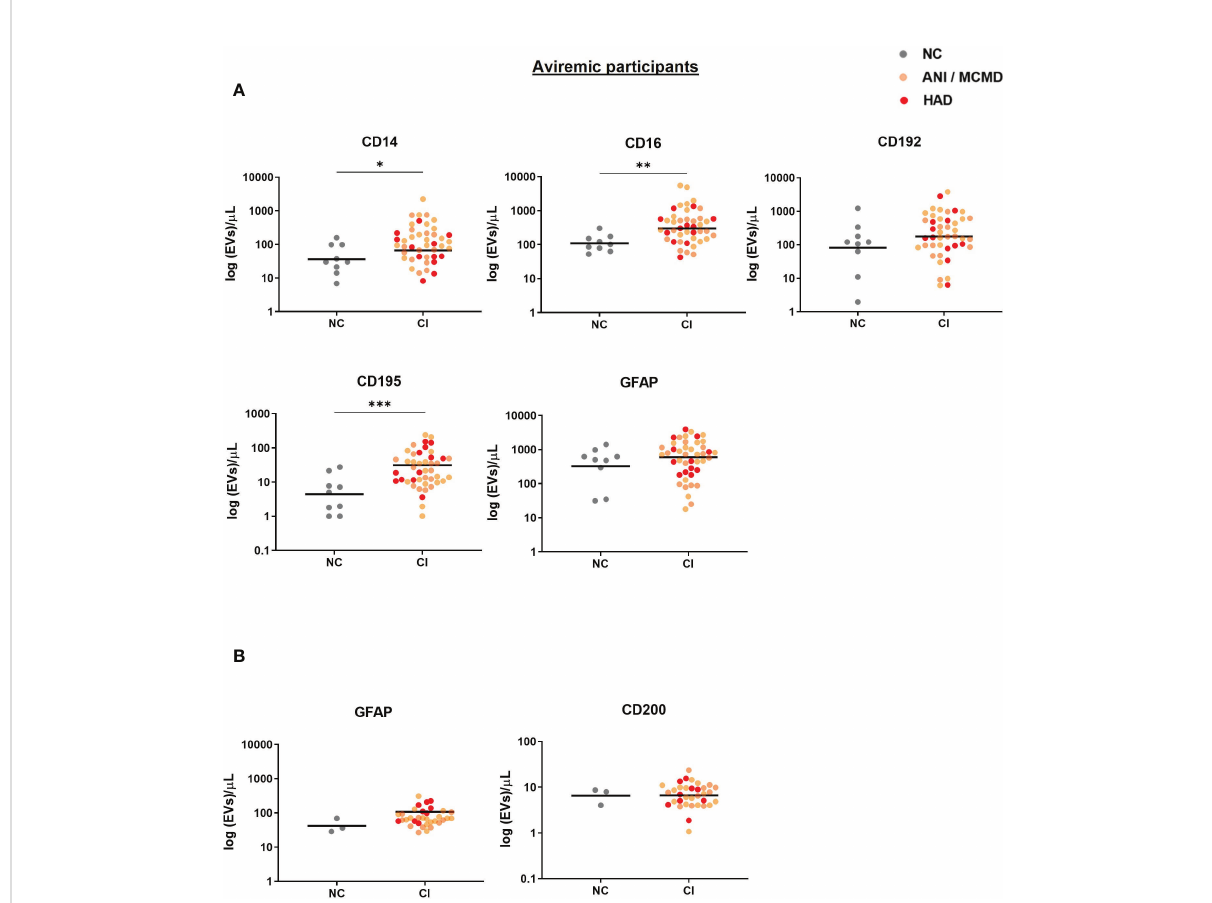
FIGURE 3 Sensitive analysis of circulating EVs expressing monocyte-associated markers and neuronal damage associate with cognitive impairment in virally- suppressed HIV+ individuals. Scatter plots of total EV numbers and concentration of each subtype of EV are shown. (A) levels of EVs expressing CD14, CD16, and CD195 were elevated in the plasma of aviremic HIV-infected individuals with CI compared to the NC group. (B) There was no signi fi cant difference in levels of GFAP+EVs and CD200+EVs in the CSF of aviremic CI compared to the NC group. P values were determined by using two-tailed Mann-Whitney test. * P <0.05, ** P <0.01, *** P <0.001. NC, normal cognition; CI, cognitive